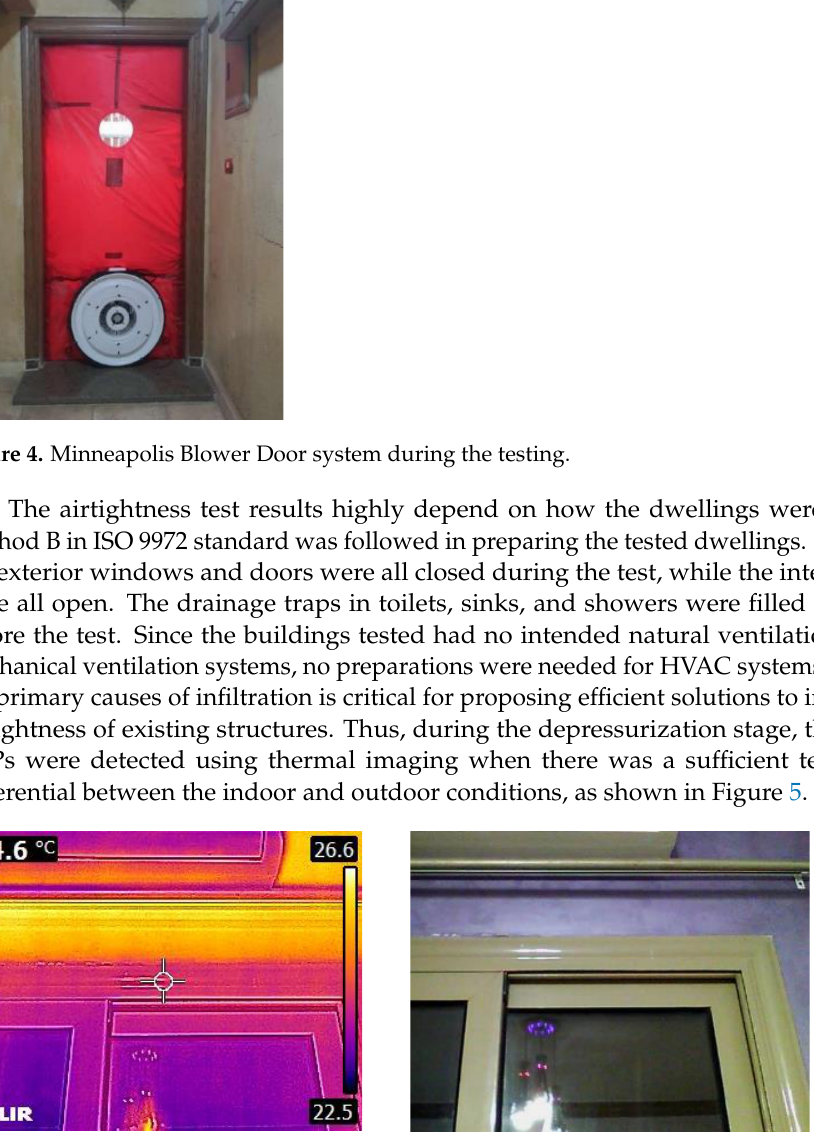
Figure 5. Example of a thermal image used to identify typical air leakage paths: showing air movement around a window.